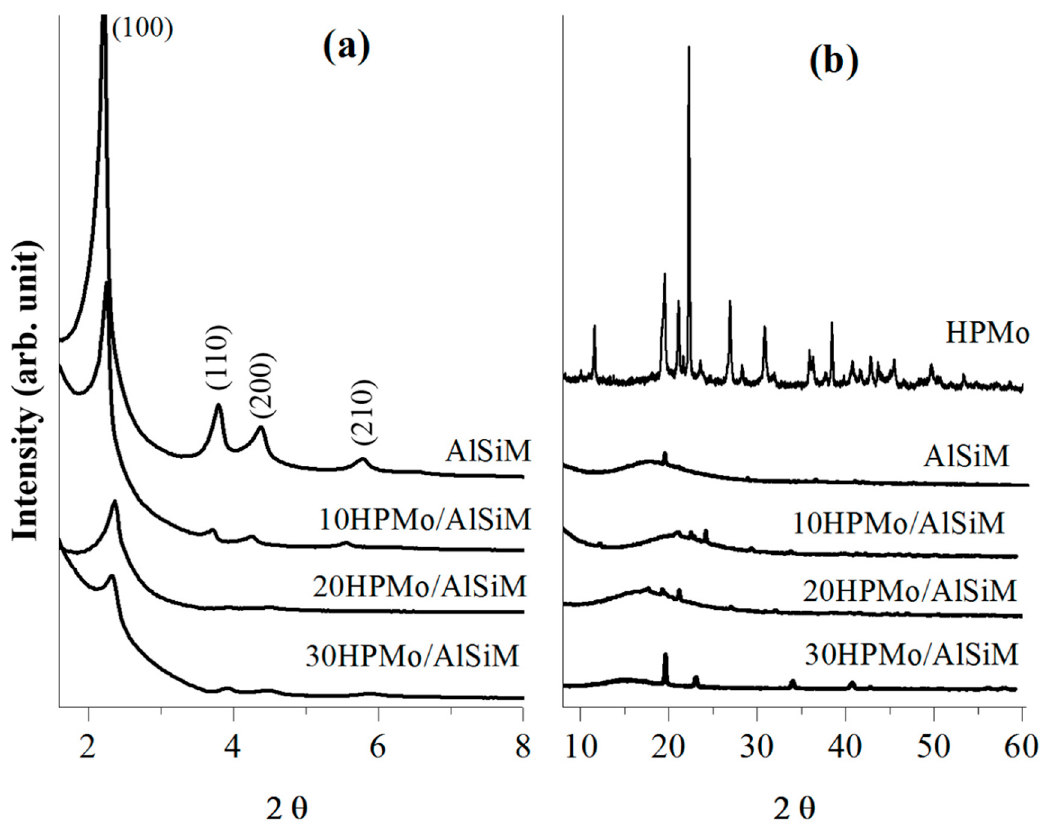
Figure 2. X-ray powder diffraction (XRD) pattern of AlSiM (calcined) and (10, 20, 30) HPMo/AlSiM samples. ( a ): Low angle, ( b ): High angle